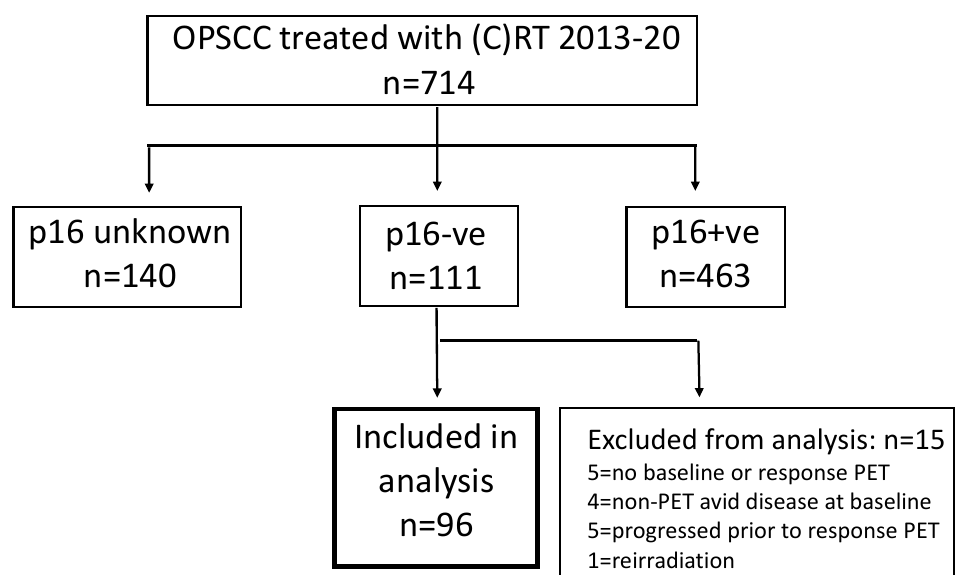
Figure 1. Flowchart showing identification of patients with p16 negative OPSCC included in analysis. Table 1 summarises the patients' demographic and treatment details. Concurrent platinum-based chemotherapy was delivered in 60/96 (61.5%) of patients. Reasons for not delivering chemotherapy were age >70 ( n = 14), limited performance status ( n = 6), alco- hol-related issues ( n = 5), cerebrovascular disease ( n = 4), renal comorbidity ( n = 2), and other ( n = 4). The median follow-up time was 26 months (range 3–60). Table 1. Patient demographics.